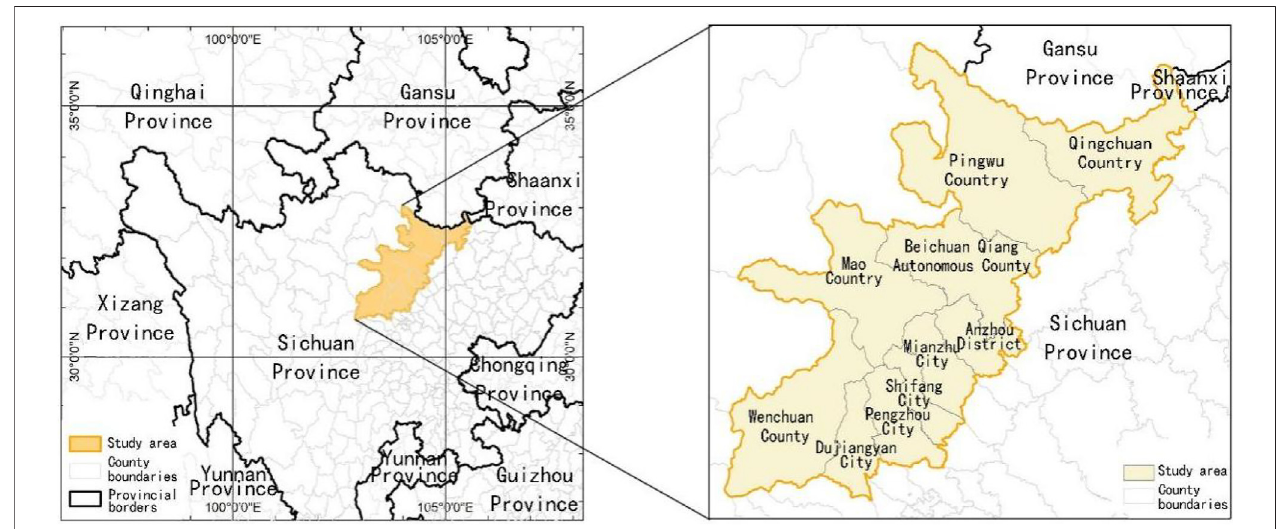
FIGURE 1 | Map of the study area.